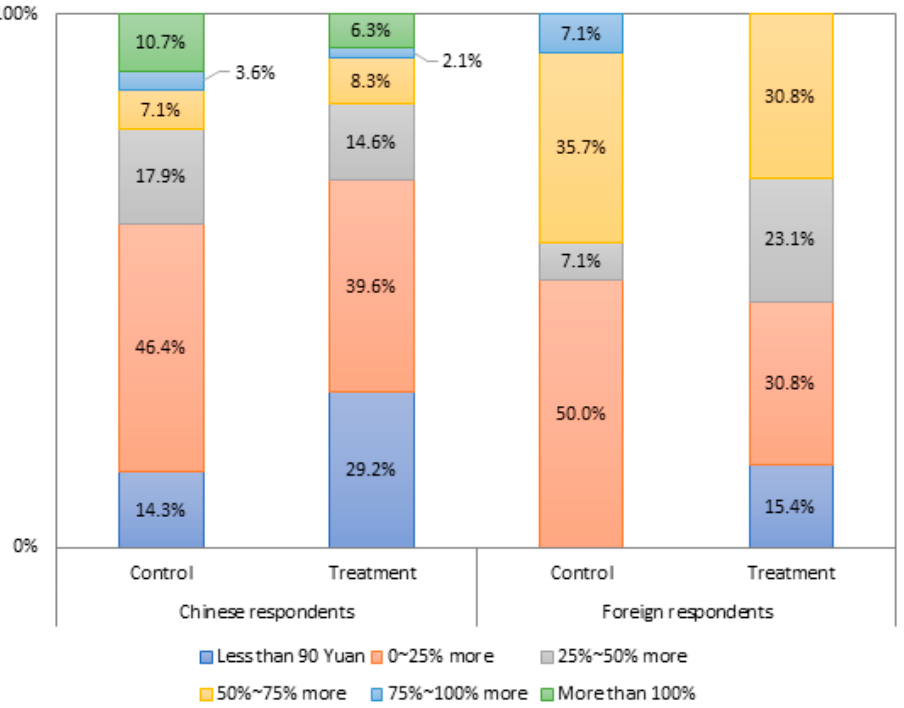
Figure 4. Percentage distribution on WTP prices against the anchor price by group. Source: Au- thors.